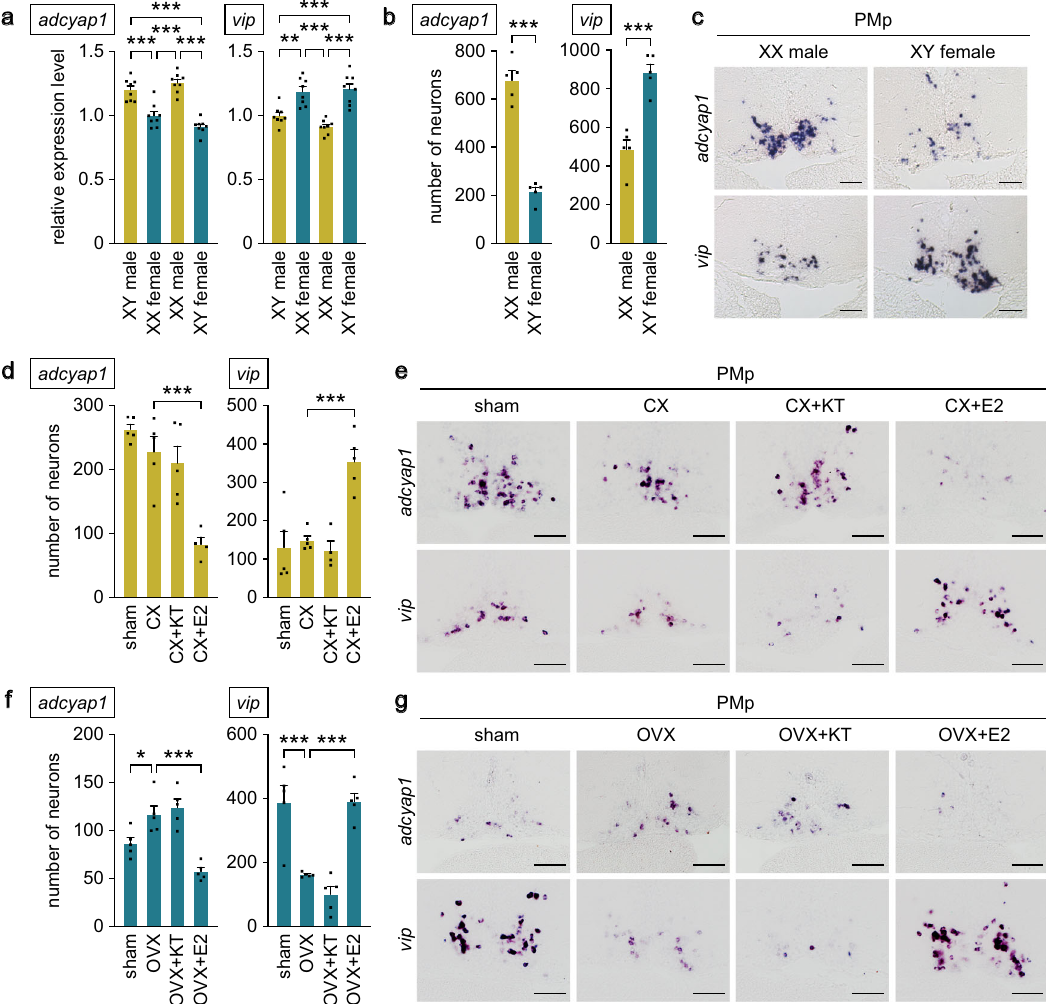
Fig. 4 Sex-biased expression of adcyap1 and vip in the POA is established by ovarian estrogen. a Levels of adcyap1 and vip expression in the brain of sex- reversed XX males and XY females versus typical XY males and XX females ( n = 8 per group). b Number of adcyap1 - and vip -expressing neurons in the PMp of sex-reversed XX males and XY females ( n = 5 per group). c Representative micrographs showing adcyap1 and vip expression in the PMp of sex- reversed XX males and XY females. Scale bars represent 50 μ m. d Number of adcyap1 - and vip -expressing neurons in the PMp of sham-operated (sham) males and castrated males exposed to vehicle alone (CX), 11-ketotestosterone (CX + KT), or estradiol-17 β (CX + E2) ( n = 5 per group, except CX + E2 for adcyap1 and CX + KT for vip , where n = 4). e Representative micrographs showing adcyap1 and vip expression in the PMp of sham, CX, CX + KT, and CX + E2 males. Scale bars represent 50 μ m. f Number of adcyap1 - and vip -expressing neurons in the PMp of sham females and ovariectomized females exposed to vehicle alone (OVX), KT (OVX + KT), or E2 (OVX + E2) ( n = 5 per group). g Representative micrographs showing adcyap1 and vip expression in the PMp of sham, OVX, OVX + KT, and OVX + E2 females. Scale bars represent 50 μ m. Quantitative data were expressed as means with error bars representing standard error of the mean. Statistical differences were assessed by Bonferroni ’ s post-hoc test ( a , d , f ) and unpaired t -test ( b ). * p < 0.05; ** p < 0.01; *** p <